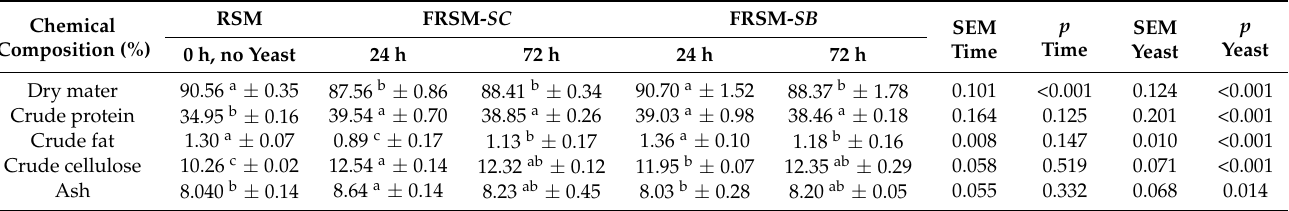
Table 2. Proximate chemical composition of the rapeseed meal samples